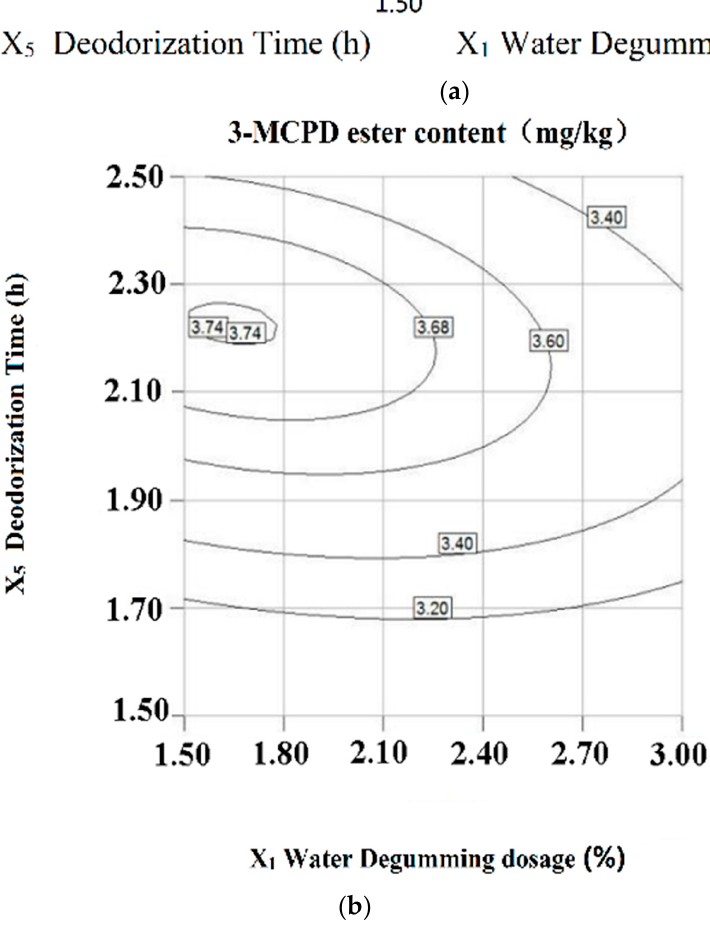
Figure 5. Response surface curves ( a ) and contours ( b ) of degumming water and deodorization time towards 3-MCPD ester (interactions of X 1 X 5 , p < 0.05).